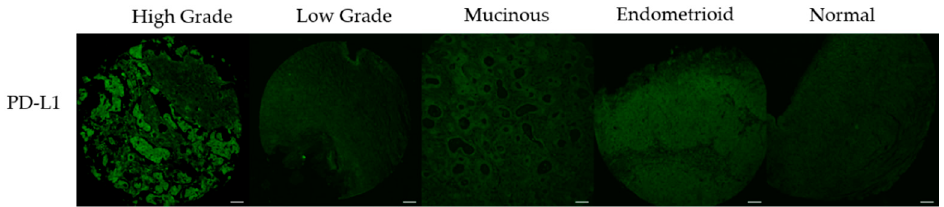
Figure 5. PD-L1 images across the pathological subtypes from the TMAs. Representative images of tumor cores matched to the oxRADD from each pathological subtype. Scale bar = 100 µm.